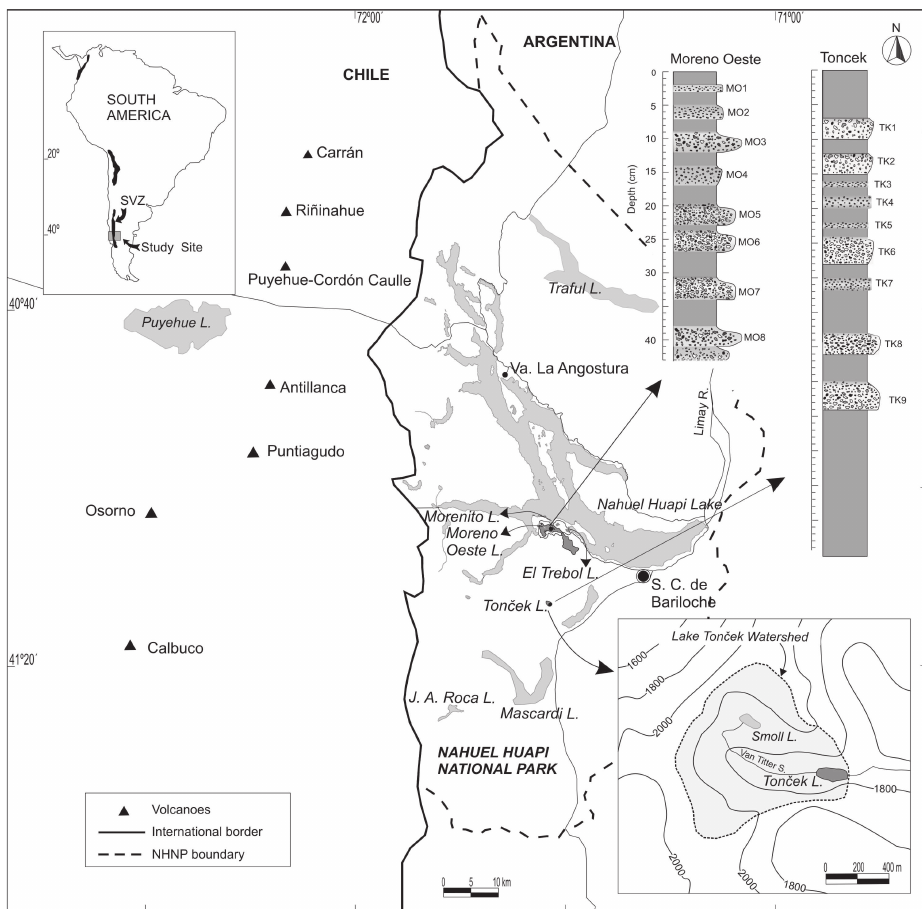
Fig. 1. Study area. Section of Nahuel Huapi National Park, Northern Patagonia, Argentina.